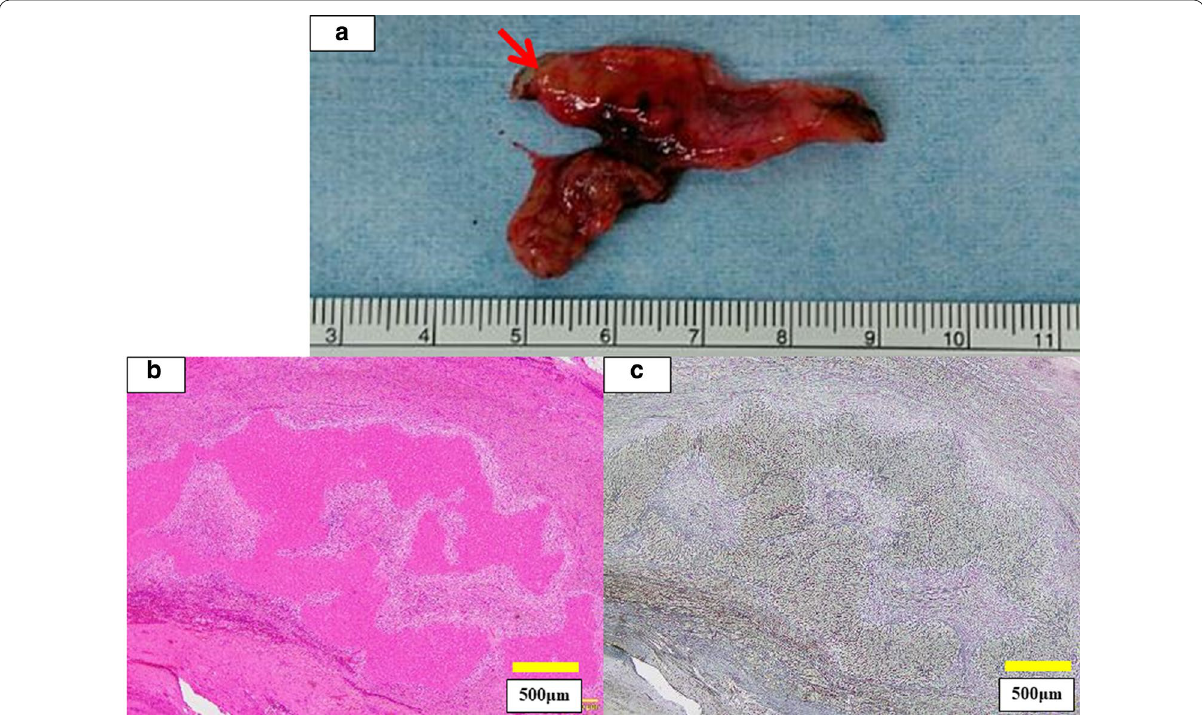
Fig. 4 Pathological findings. a Surgical resection specimen. The arrow points to the ALL. b Hematoxylin–eosin staining. c Silver impregnation